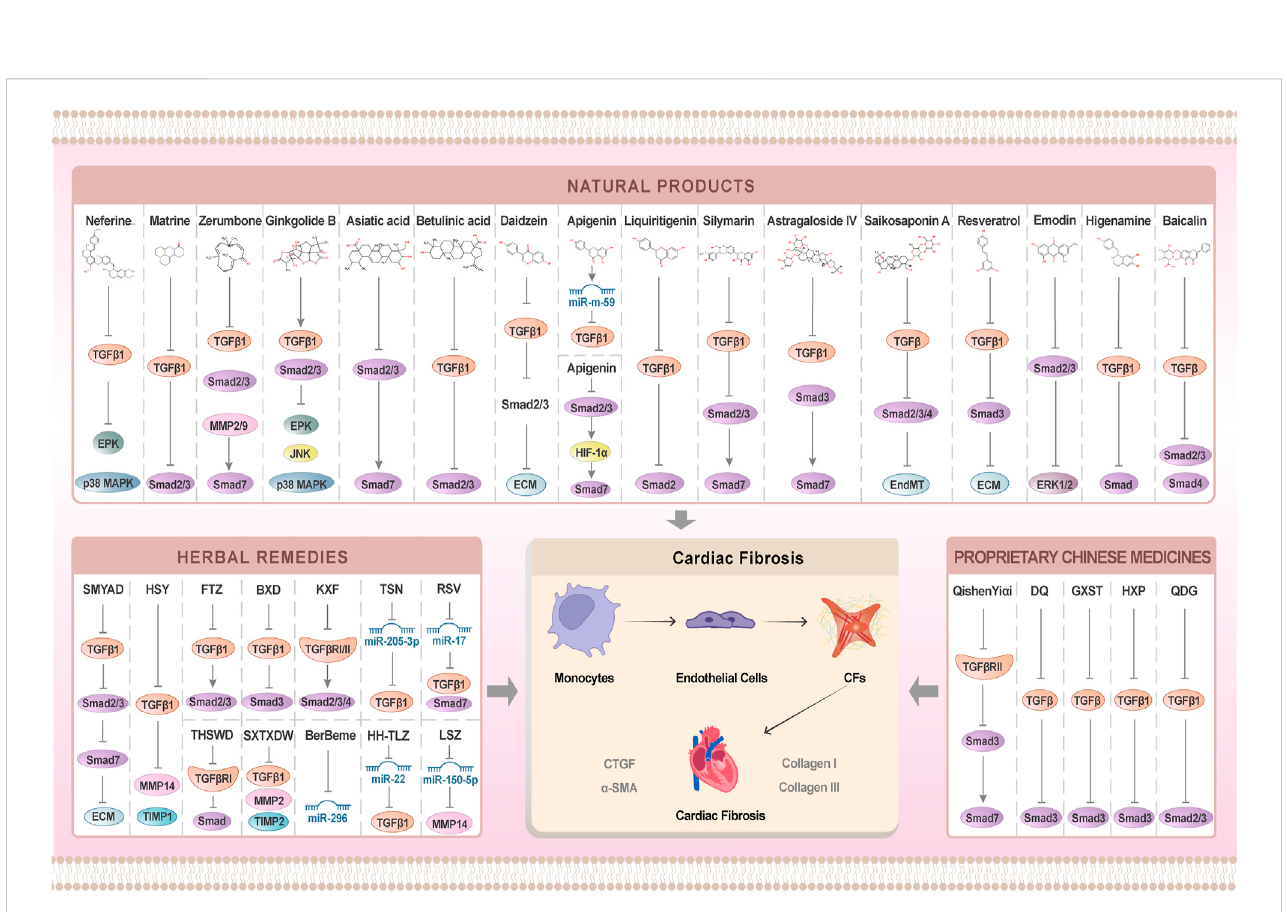
FIGURE 3 Mechanism of TCM intervention on cardiac fi brosis by regulating TGF-signaling